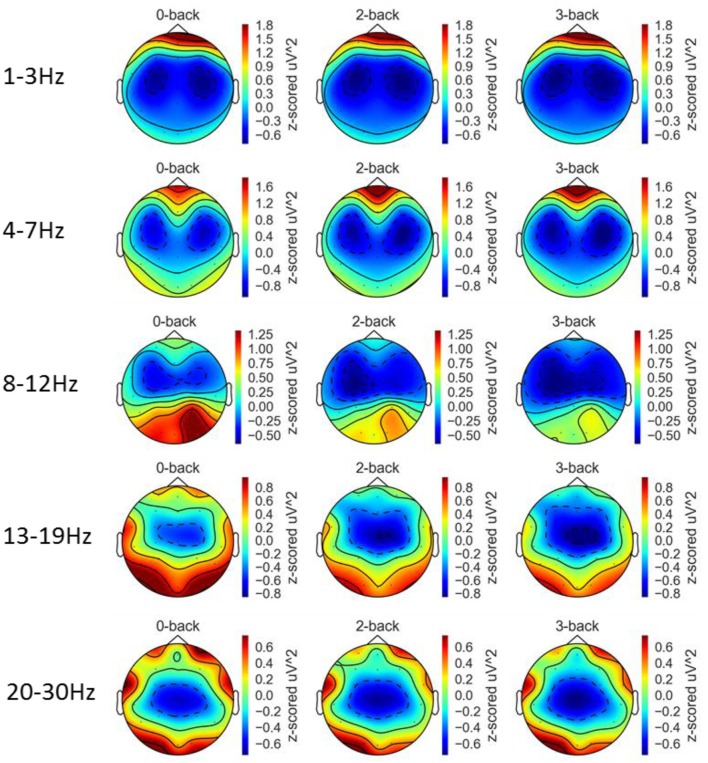
Topographic maps of EEG band powers at the five frequency bands and three workload conditions averaged over 21 participants.